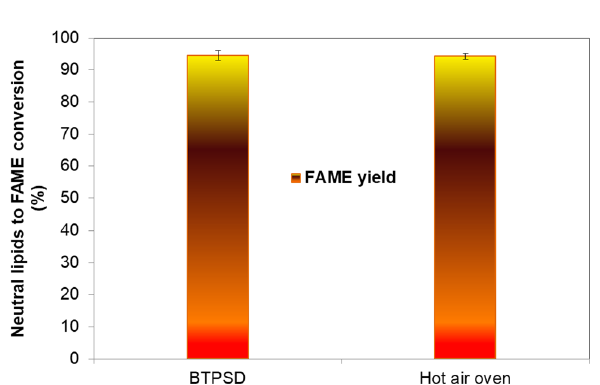
Figure 6. The FAME yield of C. vulgaris neutral lipids dried under BTPSD and hot air oven.